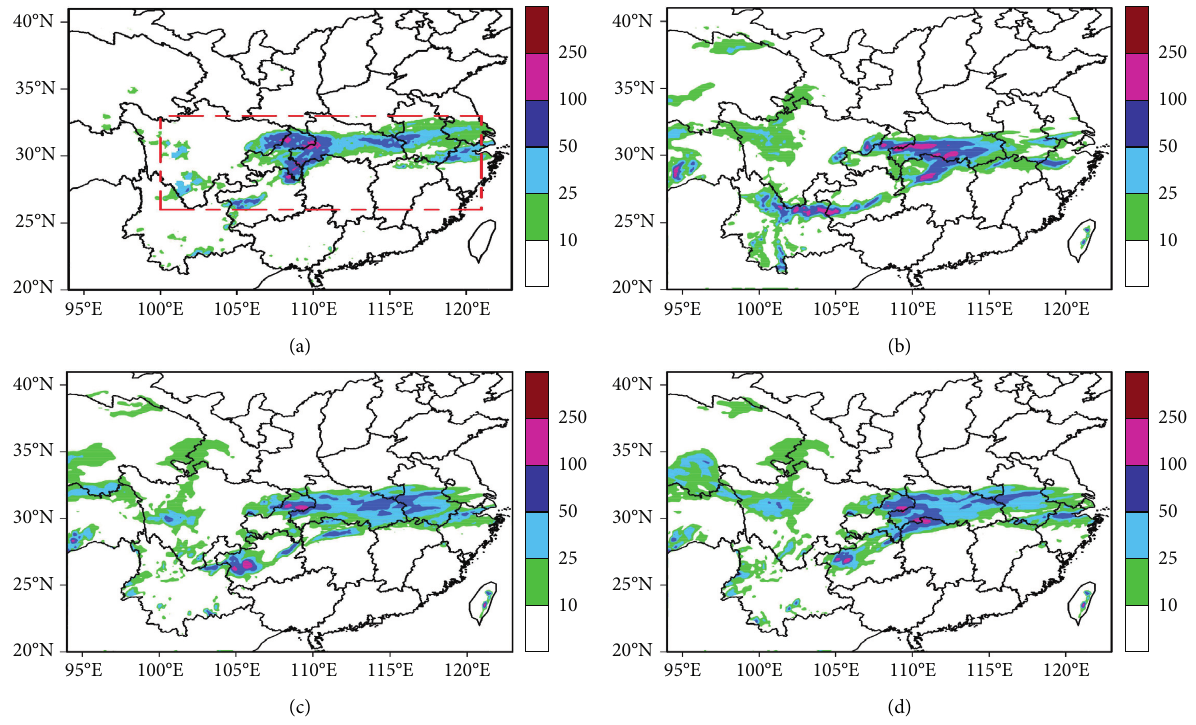
Figure 7: The 24-hour accumulated precipitation (unit: mm) from 0000 UTC 24 June 2016 to 0000 UTC 25 June 2016 from the hourly intensive automatic rainfall stations of the China Meteorological Administration observations (a), CN experiment (b), DY experiment (c), and AL experiment (d).